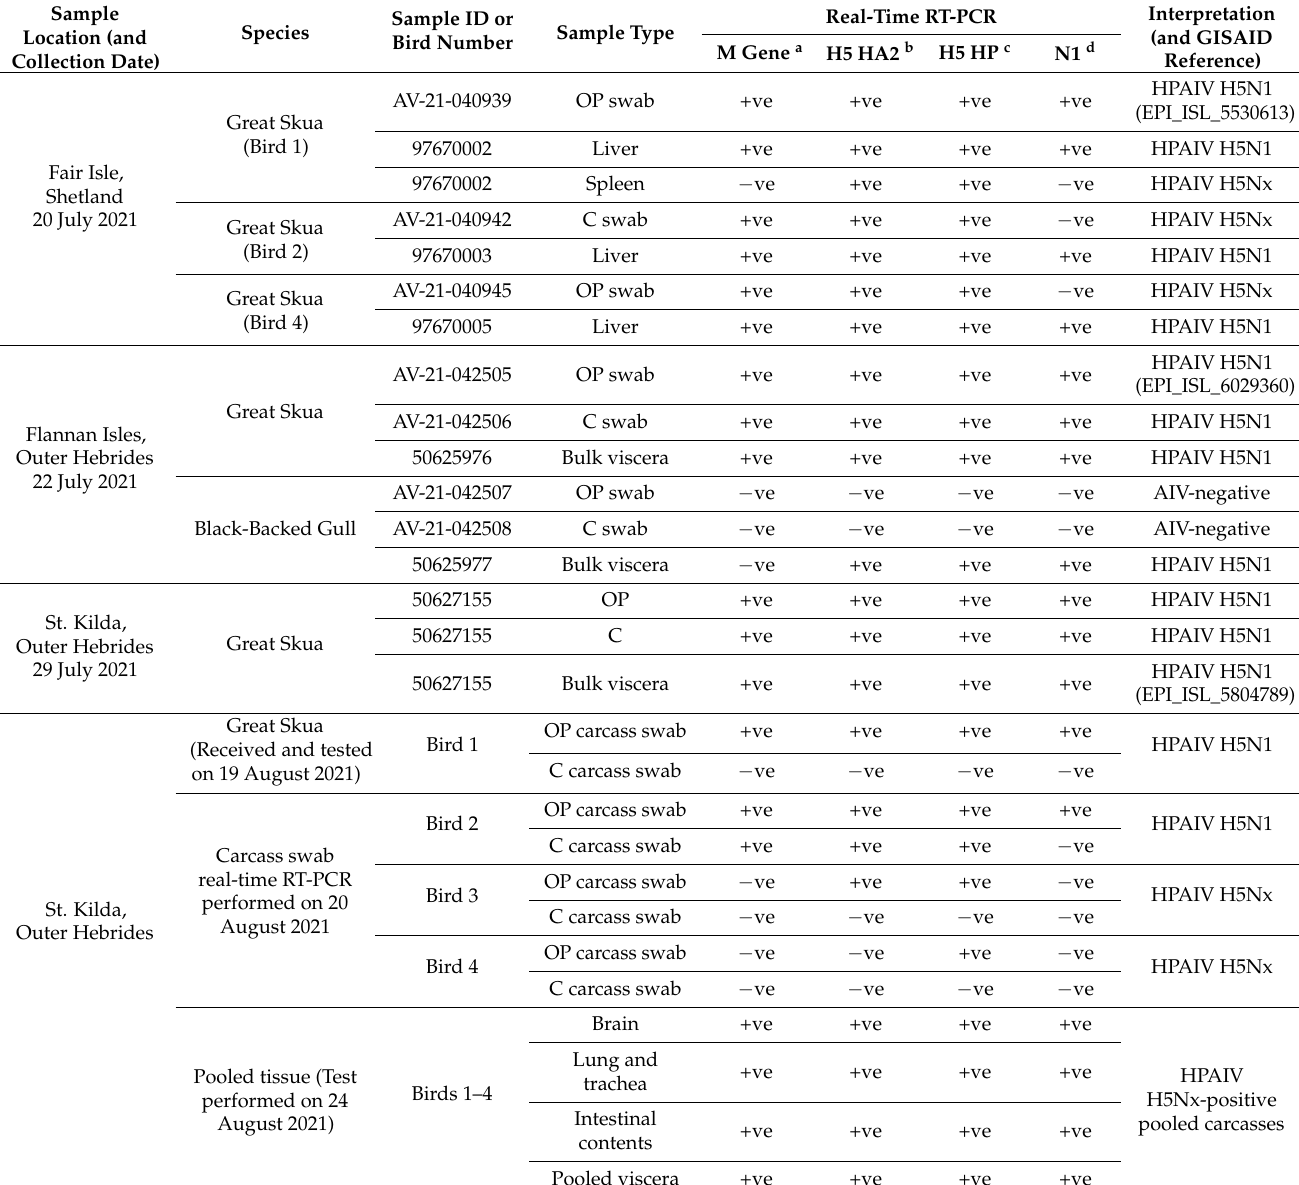
Table 1. Overview of molecular testing of samples submitted across the disease